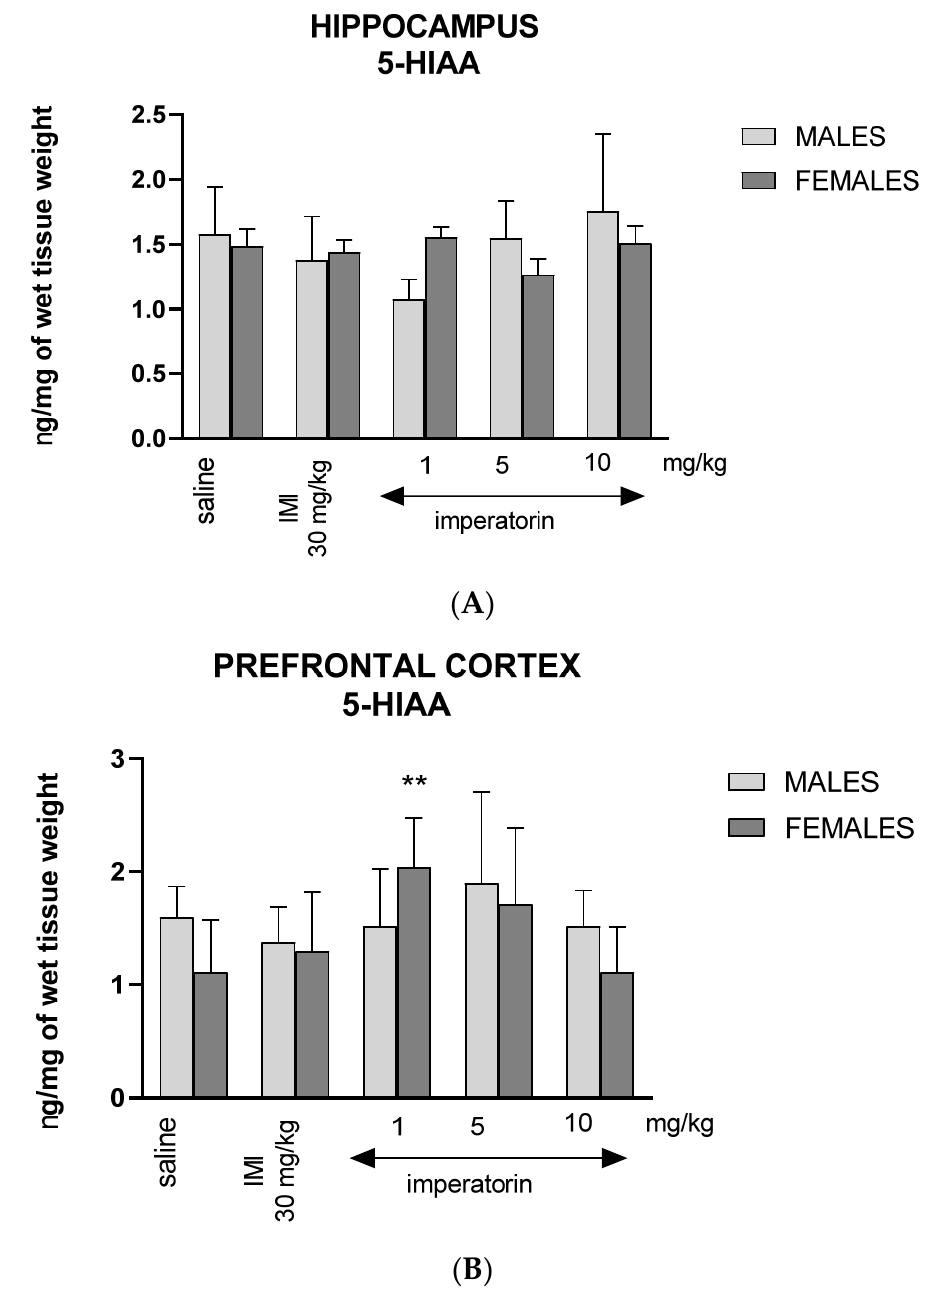
Figure 4. 5-Hydroxyindoleacetic acid (5-HIAA) levels in the hippocampus ( A ) and prefrontal cortex ( B ) after imipramine (IMI) and imperatorin injections ( i.p. ) and comparison of sex differences. Imipramine (IMI, 30 mg/kg.) and imperatorin (1, 5, and 10 mg/kg.) were administered 30 min before the FST. The hippocampus ( A ) and prefrontal cortex ( B ) were dissected immediately after the test; n = 8–10; mean ± SD, ** p < 0.01 vs. female saline-treated group; Bonferroni’s test.